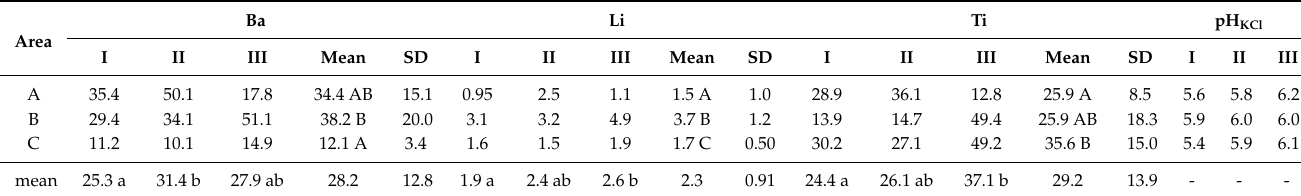
Table 5. Ba, Li and Ti concentration in soil (mg kg − 1